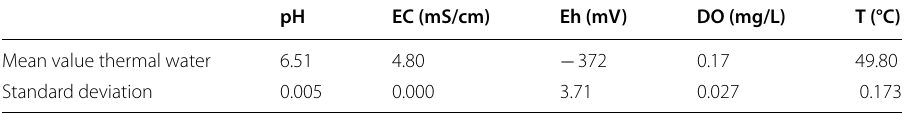
Table 3 Background values of physicochemical parameters of the thermal water (mean values and standard deviation of five samples collected over a period of 17